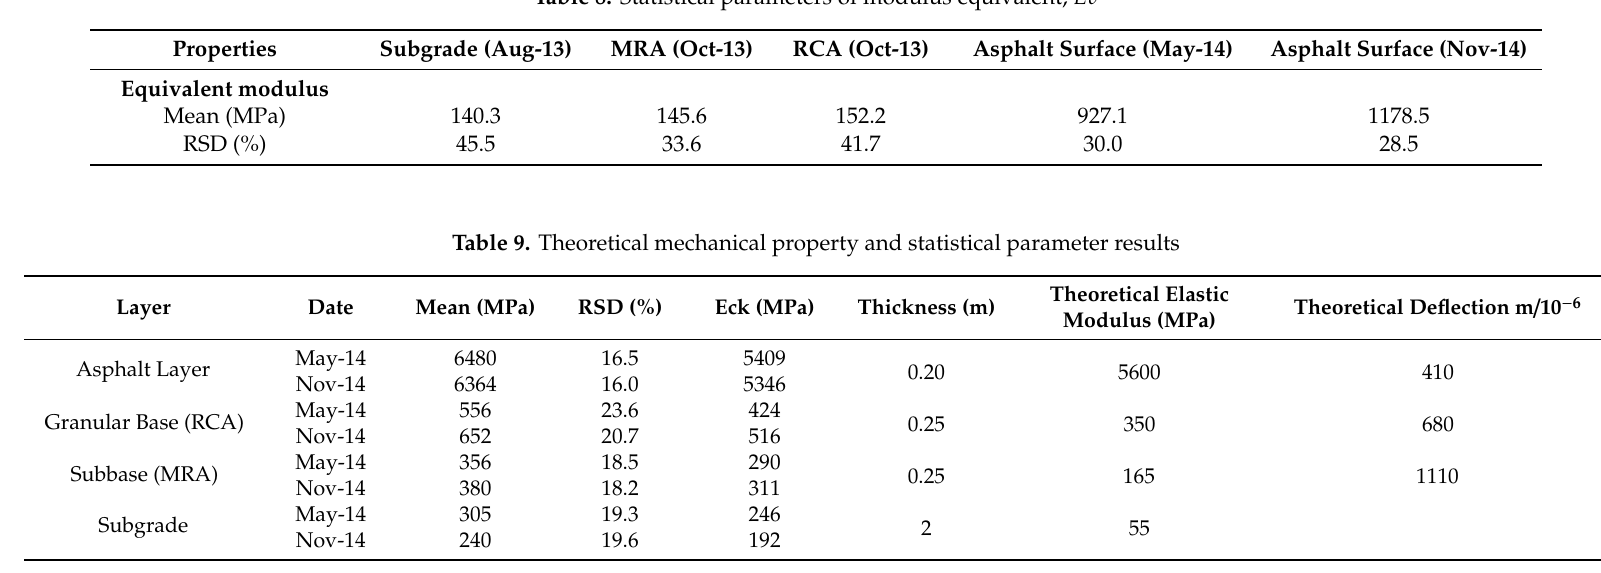
Table 8. Statistical parameters of modulus equivalent, Ev